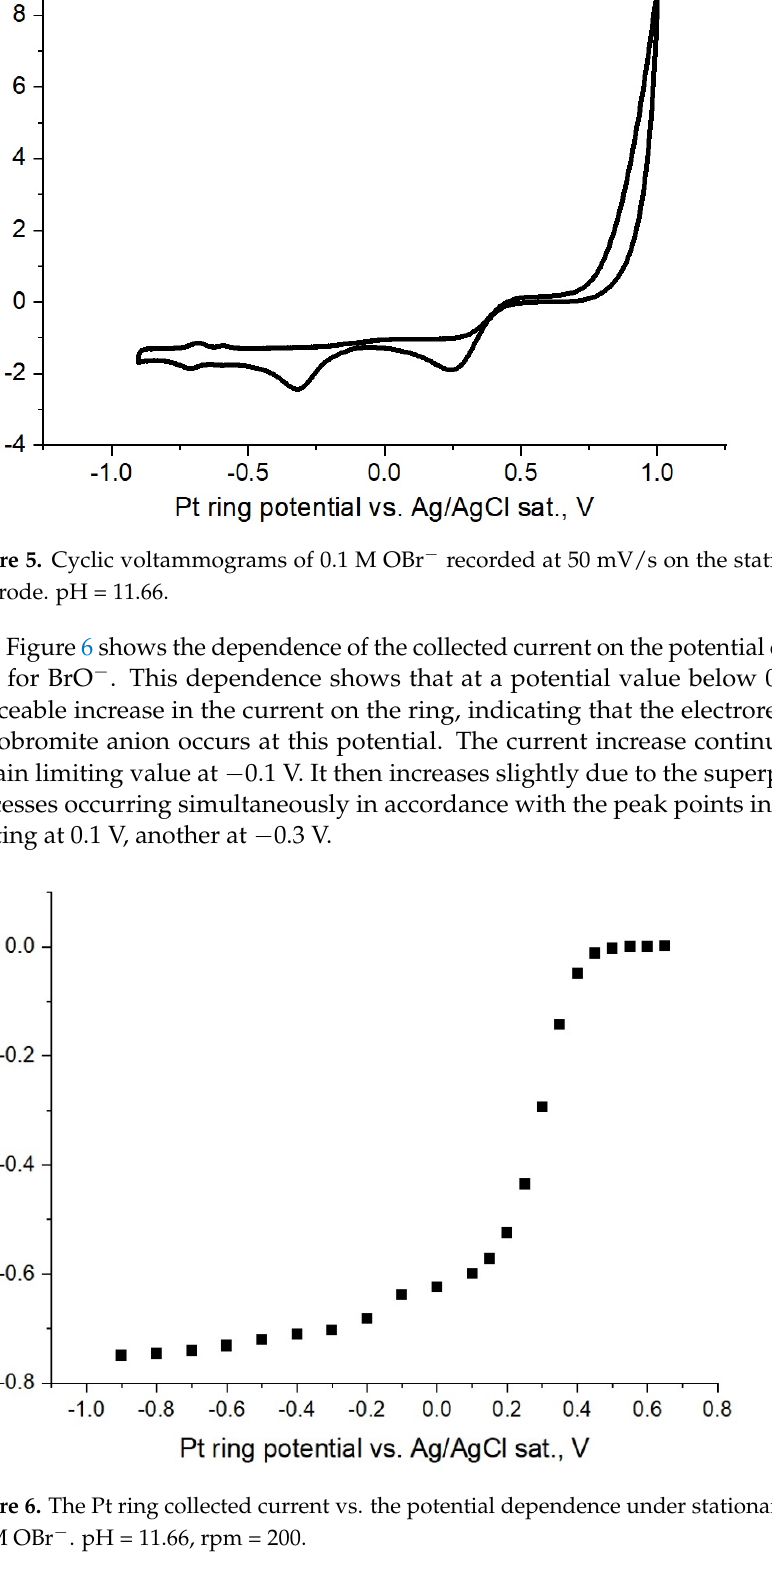
0.1 M OBr − . pH = 11.66, rpm = 200.